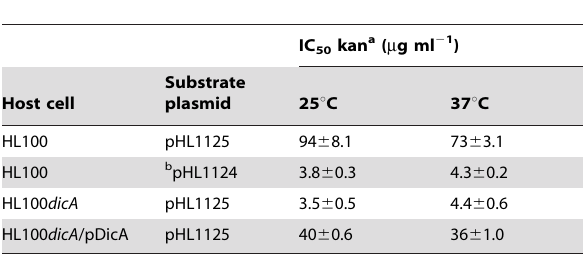
Table 3. IC 50 kan at 25 u C and 37 u